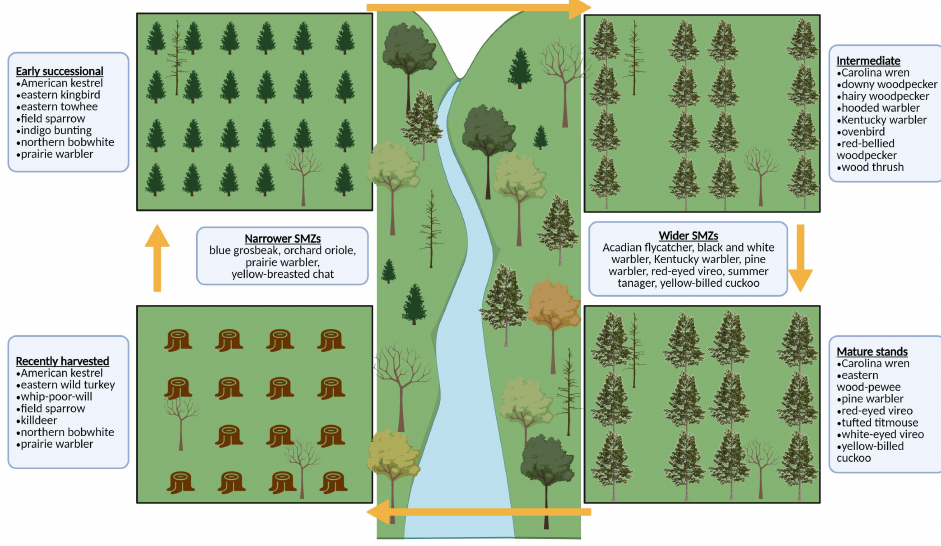
Figure 4. Schematic summarizing a sample of species typical of avian communities associated with recently harvested, early successional, intermediate, and mature managed pine stands, and narrow and wide streamside management zones (SMZs) in southeastern managed pine landscapes. Created with BioRender.com (accessed on 4 October